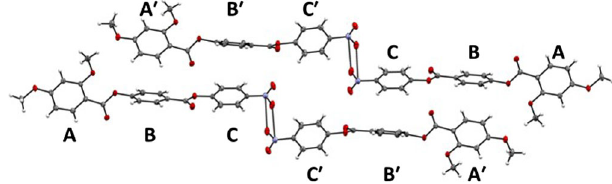
15. Structure of RM734 in the solid state. The dashed lines indicate the close contacts between ð O — N ð in adjacent nitro Þ nitro Þ molecules (two per pair). Rings are labeled A, B, C (A 0 , B 0 , C 0 on adjacent pair) as per discussion in the text. FIG. 16. Numerical solution of the global minimization of the free energy in 1D for t ¼ 0 . 98 t to obtain the solution, which corresponds to the minimum of the energy. For C 1 S 2 ¼ 8 pN, C 5 S 3 ¼ 4 pN, γ ¼ 2 . 8 × 10 − 6 V, and b ¼ 4 × 10 − 5 Vm = ð As Þ